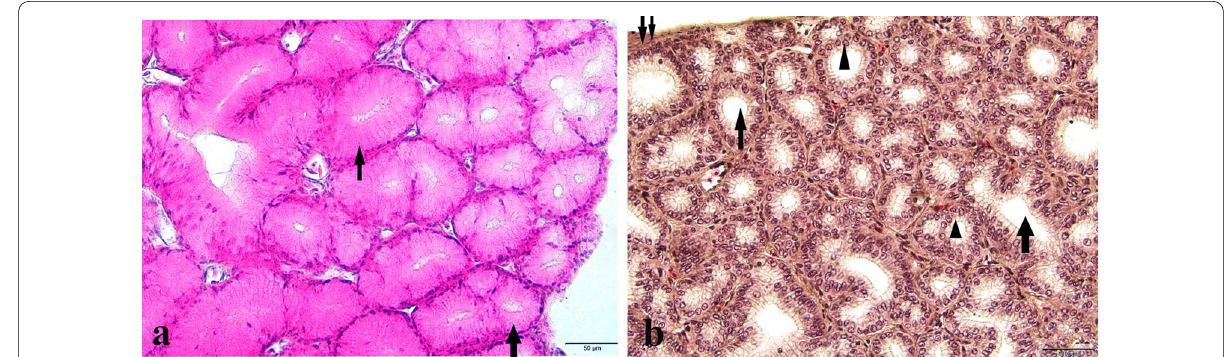
Fig. 3 A photomicrograph of a transverse section of the Harderian gland of Egyptian agama, Trapelus mutabilis , showing the Harderian gland is a compound tubuloacinar type (arrow) consisting of columnar and pyramidal glandular cells (arrowhead) with rounded nuclei and lumina that are variable in size (arrow); thin connective tissue capsule (double arrow) and blood vessels (arrowhead) penetrate into the glandular tissue (H &E, 400, Masson’s trichromic, 200) × ×